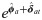
Spatial and spatio-temporal effects together, i.e., eϕ^a+δ^at.